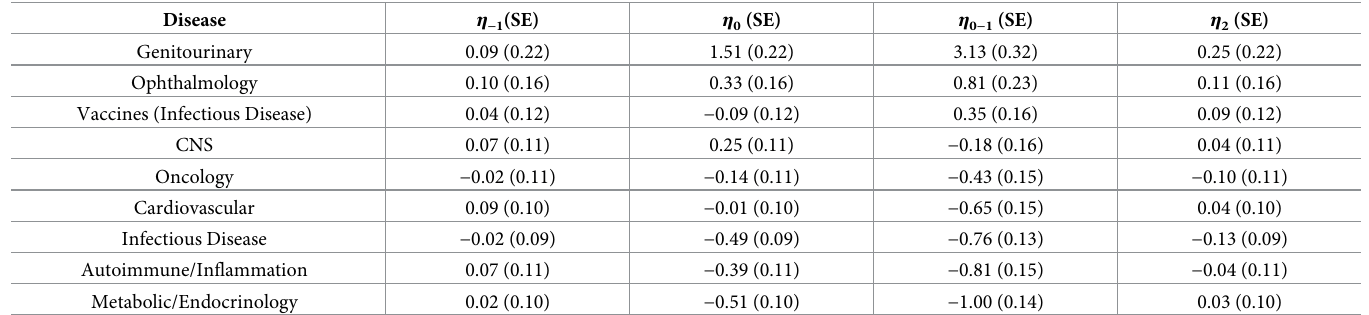
Table 6. Disease therapeutic